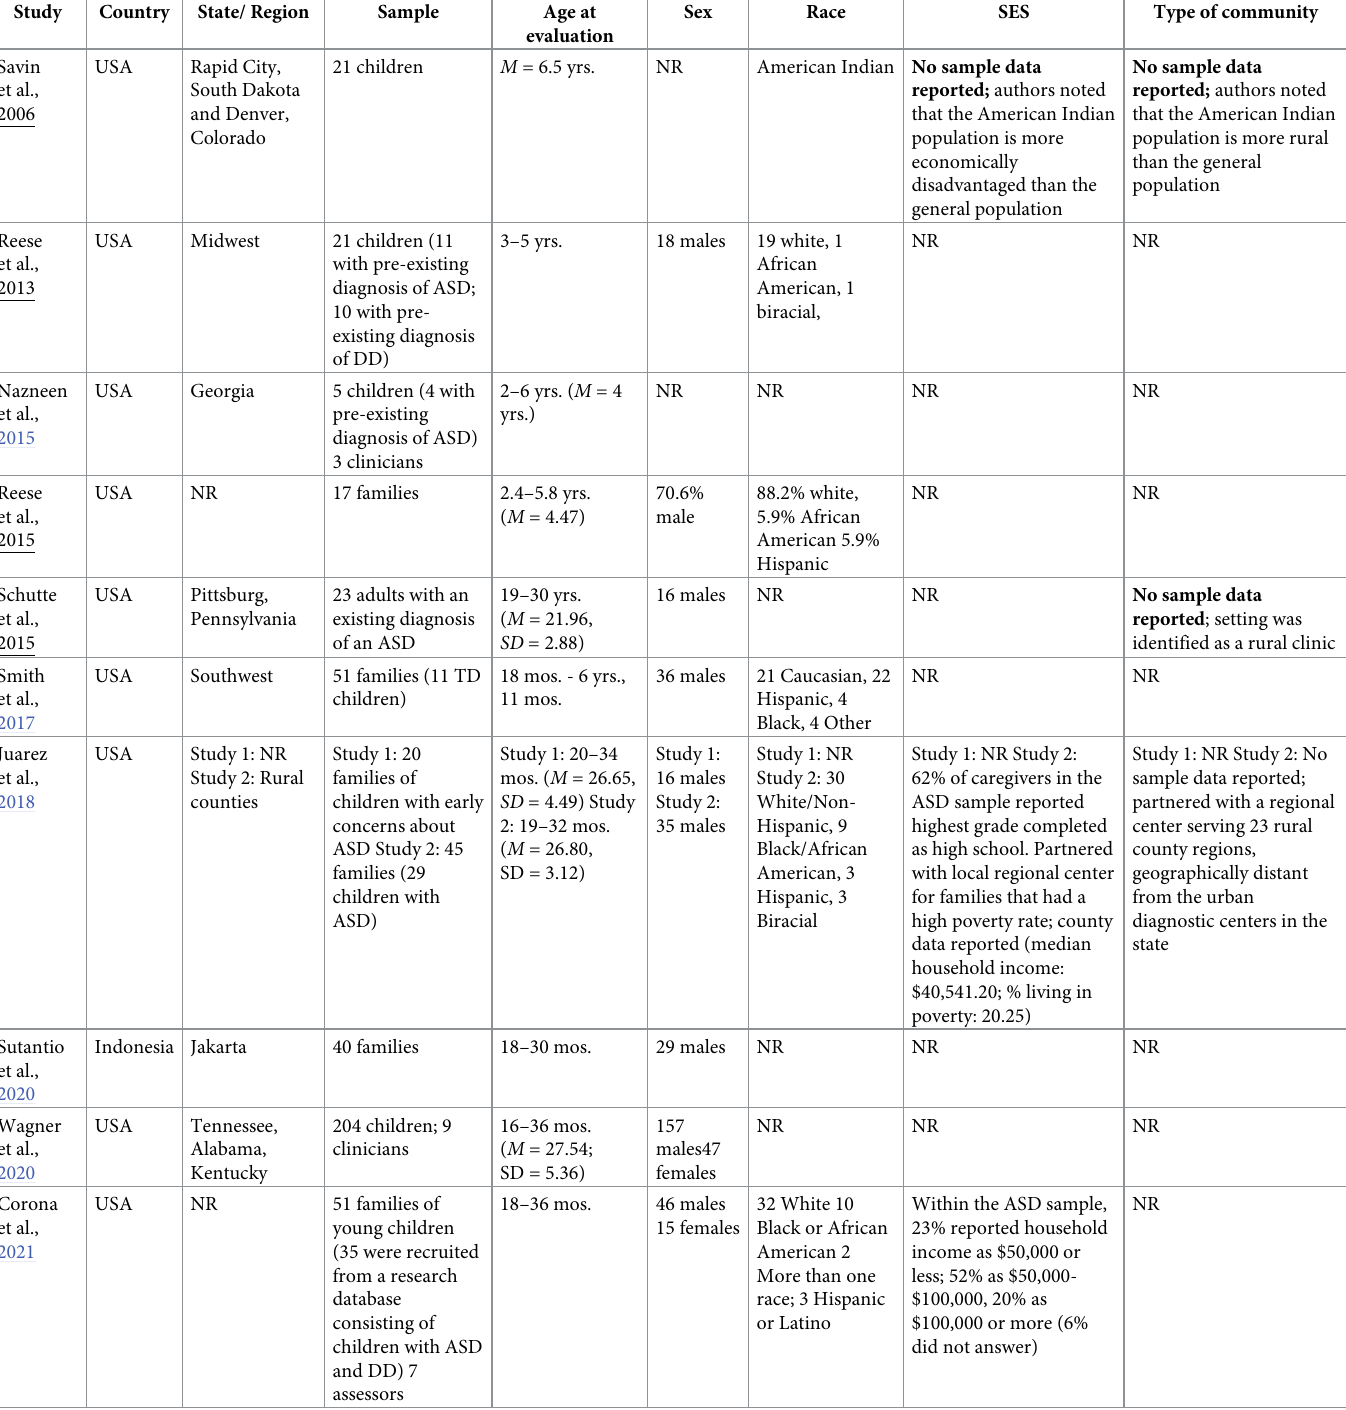
Table 2. Sample characteristics of included